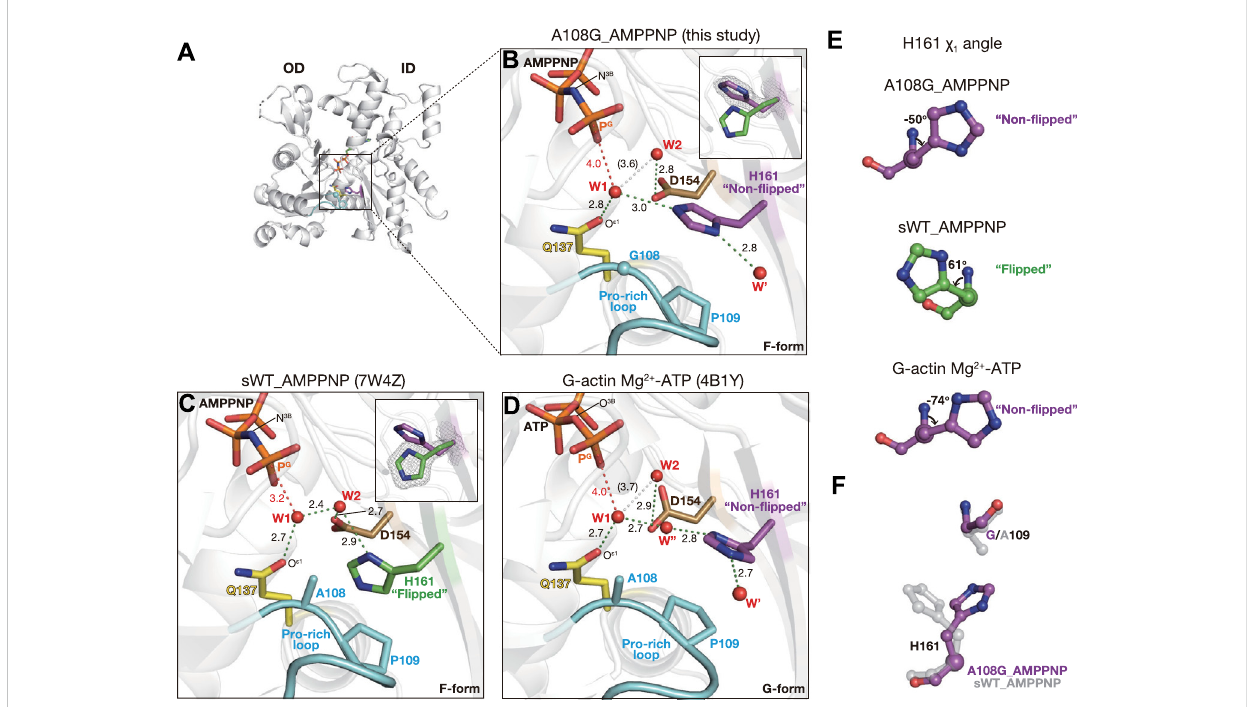
FIGURE 2 StructureofA108G_AMPPNP. (A) OverallstructureofA108G_AMPPNP (backview). (B – D) Close-up viewsoftheactivesiteofA108G_AMPPMP [this study: (B) ], sWT_AMPPNP [PDB code: 7W4Z, (C) ], and Mg 2+ -ATP G-actin [PDB code: 4B1Y, (D) ]. Nucleotides, key residues, and water molecules are shown. Red dotted lines are the distance between the gamma phosphorous atom (P G ) of ATP/AMPPNP and putative lytic water molecules (W1). Green dotted lines represent the hydrogen bonds. White dotted lines indicate W1 and W2 that are too far apart to form a hydrogen bond. Insets in B and C show His161 in both fl ipped and non- fl ipped rotamer conformations, along with the omit map (contoured at 4 σ ), to specify the selected conformation in each structure. (E) χ 1 angle of H161 in A108G_AMPPNP (top), sWT_AMPPNP (middle), and Mg 2+ -ATP G-actin (bottom). (F) Relation between His161 and the 109 position residue in A108G_AMPPNP (purple) and sWT_AMPPNP (transparent gray). A108G_AMPPNP His161 fl ips to avoid the methyl group of